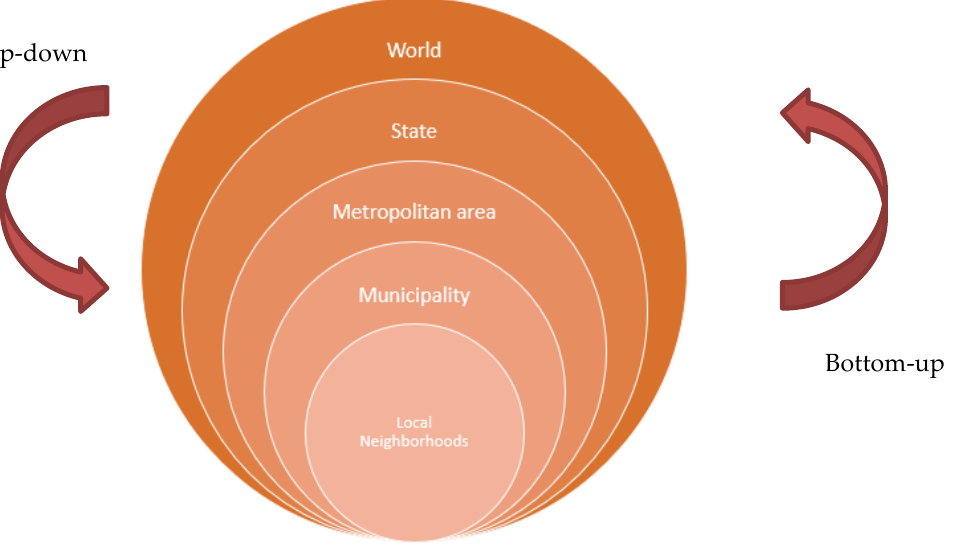
Figure 3. Articulation between authorities. Source: own elaboration.